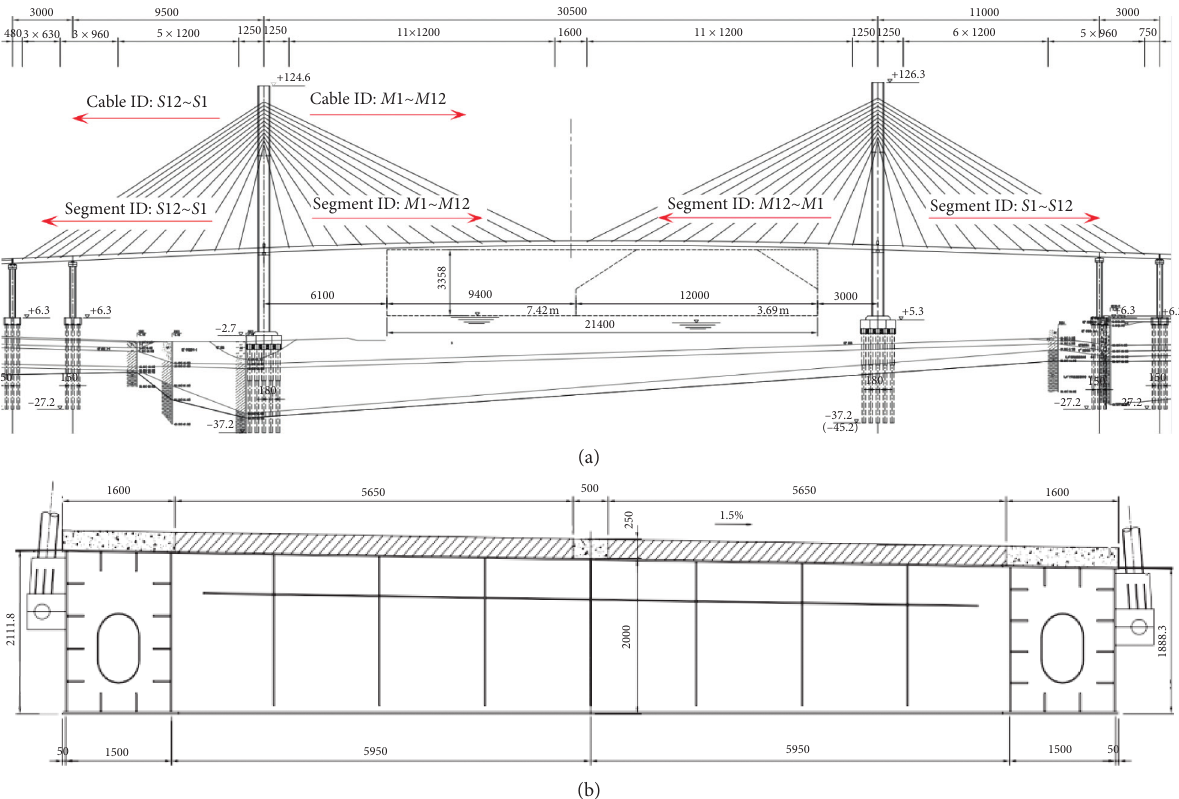
Figure 2: General layout and the cross section of the girder. (a) General layout (cm). (b) Cross section of the main girder (cm).